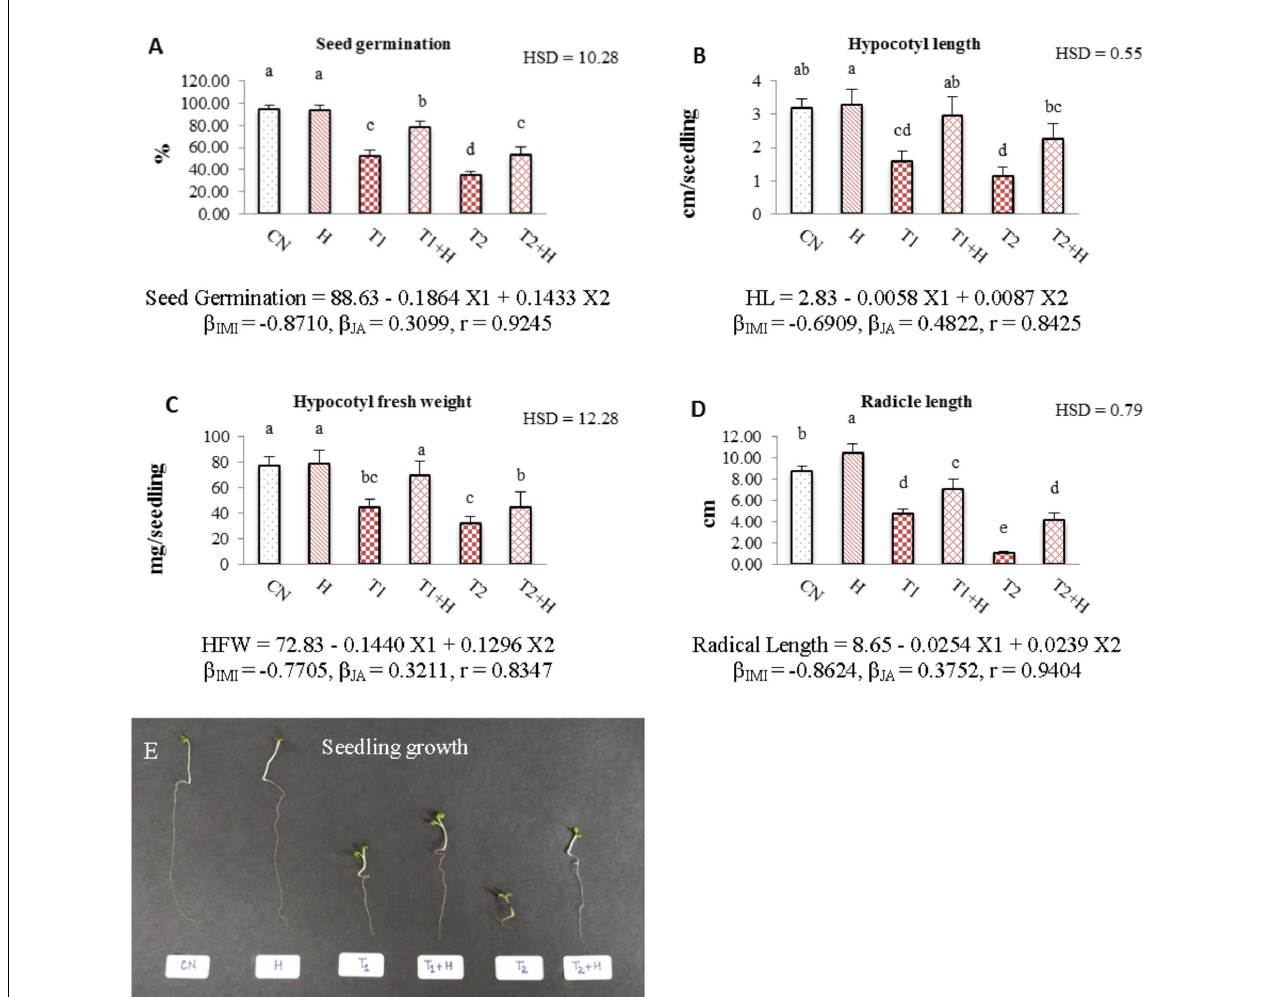
FIGURE 1 | Effect of JA seed soaking on growth parameters of Brassica juncea seedlings under IMI stress. Data shown here are mean ± SD ( n = 10). Means with same letters are not significantly different from each other, IMI, imidacloprid (X1); JA, jasmonic acid (X2); T1, 200 mg · L − 1 (IMI); T2, 250 mg · L − 1 (IMI); H , 100 nM (JA); r, multiple correlation coefficient. β = β -regression coefficient. A = seed germination; B = hypocotyl length; C = hypocotyl fresh weight; D = radicle length; E = seedling